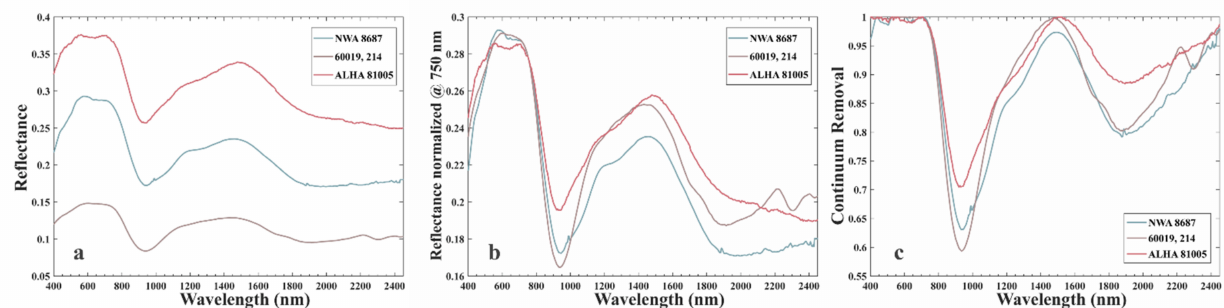
Figure 8. Comparisons of NWA 8687 and the best-matched RELAB reflectance spectra of returned lunar sample 60019, 214, and lunar meteorite ALHA 81005 using SAM algorithm. ( a ) Reflectance. ( b ) Spectra normalized at 750 nm, and ( c ) spectra after continuum removal. Spectrum ID for sample 60019.214 and ALHA 81005 is S3LS07 and CFLM34,